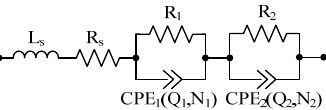
Figure 13. Equivalent electrical circuit (EEC) configuration based on ZARC elements used for fitting the measured impedance spectra of the LFP/C battery. CPE: constant phase element.